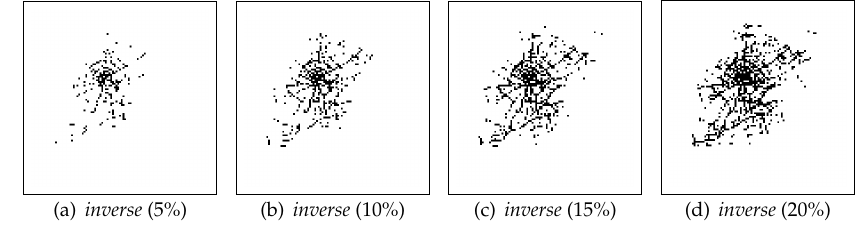
Figure 11. ( a – d ) Show the layout of roadside units deployed by inverse for covering 5%, 10%, 15%, and 20% (respectively) of the road network. When compared to balanced and direct , we notice that inverse presents the lowest density of roadside units around the epicenter of